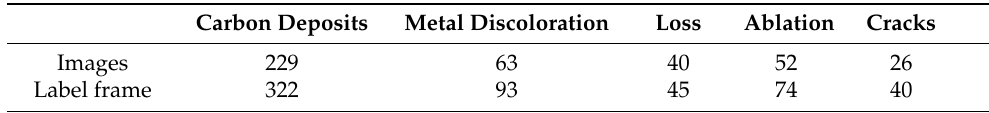
Table 1. Damage statistics in swirler dataset.